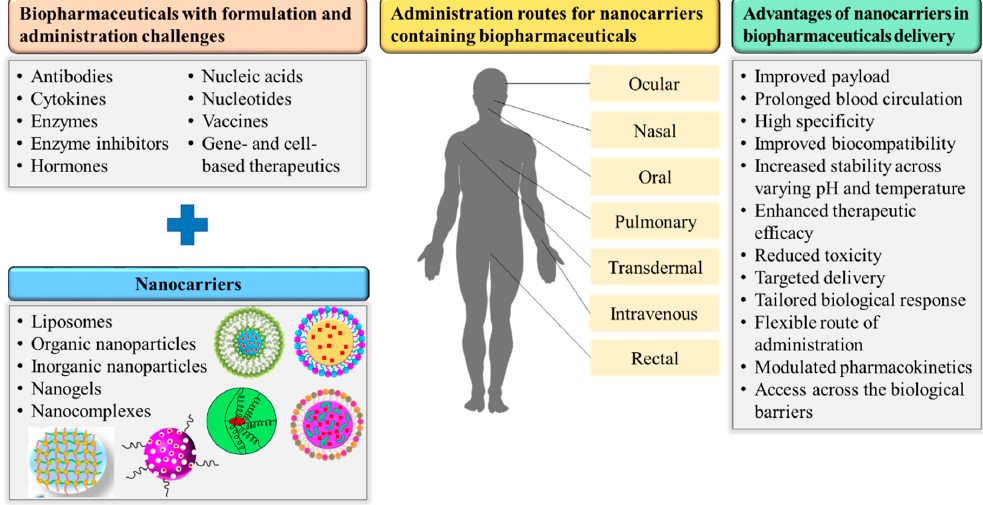
Figure 3. Nanocarrier-based approaches for efficient biopharmaceutical delivery.